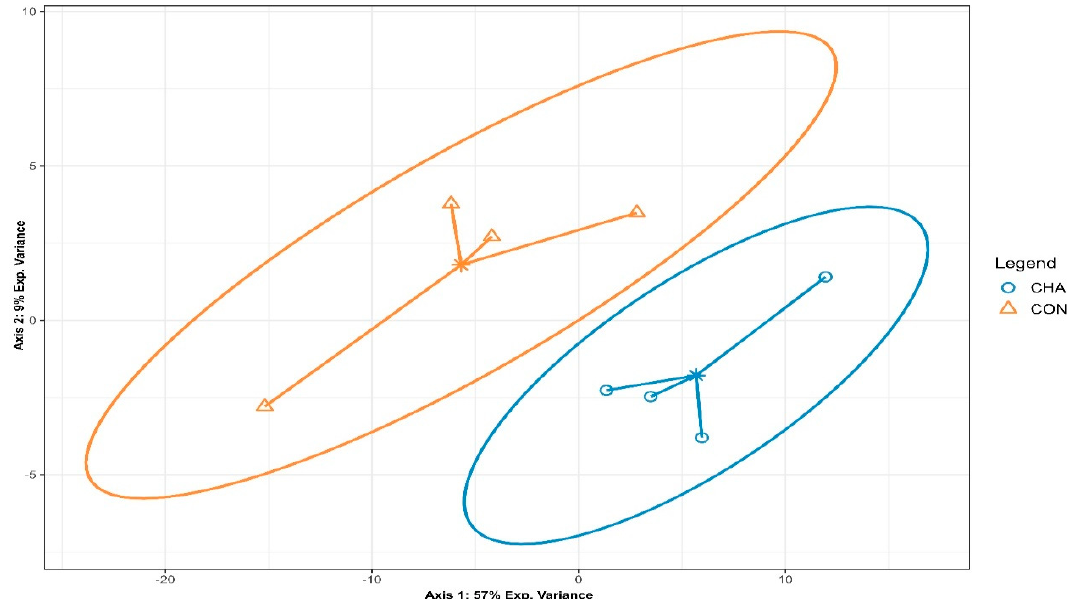
Figure 3. Partial least squares discriminant analysis of the microbial community composition in beef cattle during the acidosis challenge. CHA = corn-induced acidotic challenge, CON = control (no challenge).